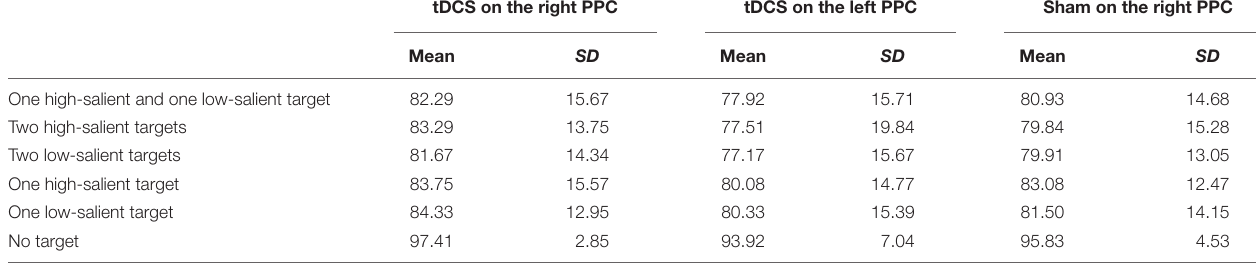
TABLE 1 | Means and standard deviations (SD) in accuracy for different stimulation conditions. tDCS on the right PPC tDCS on the left PPC Sham on the right PPC